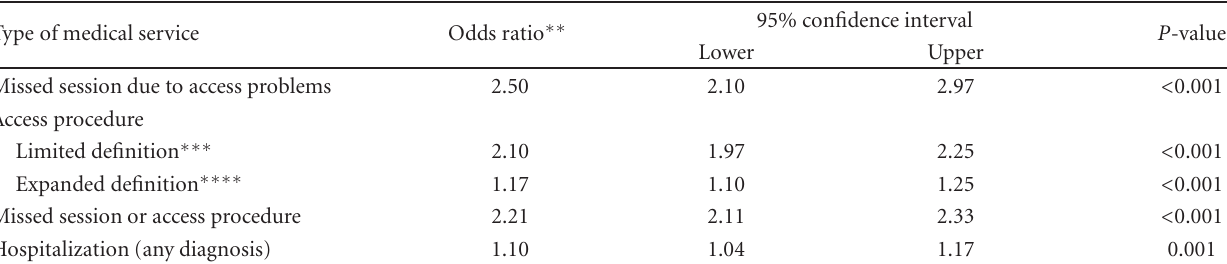
Table 3: Repeated measures analysis ∗ of medical services associated with catheter